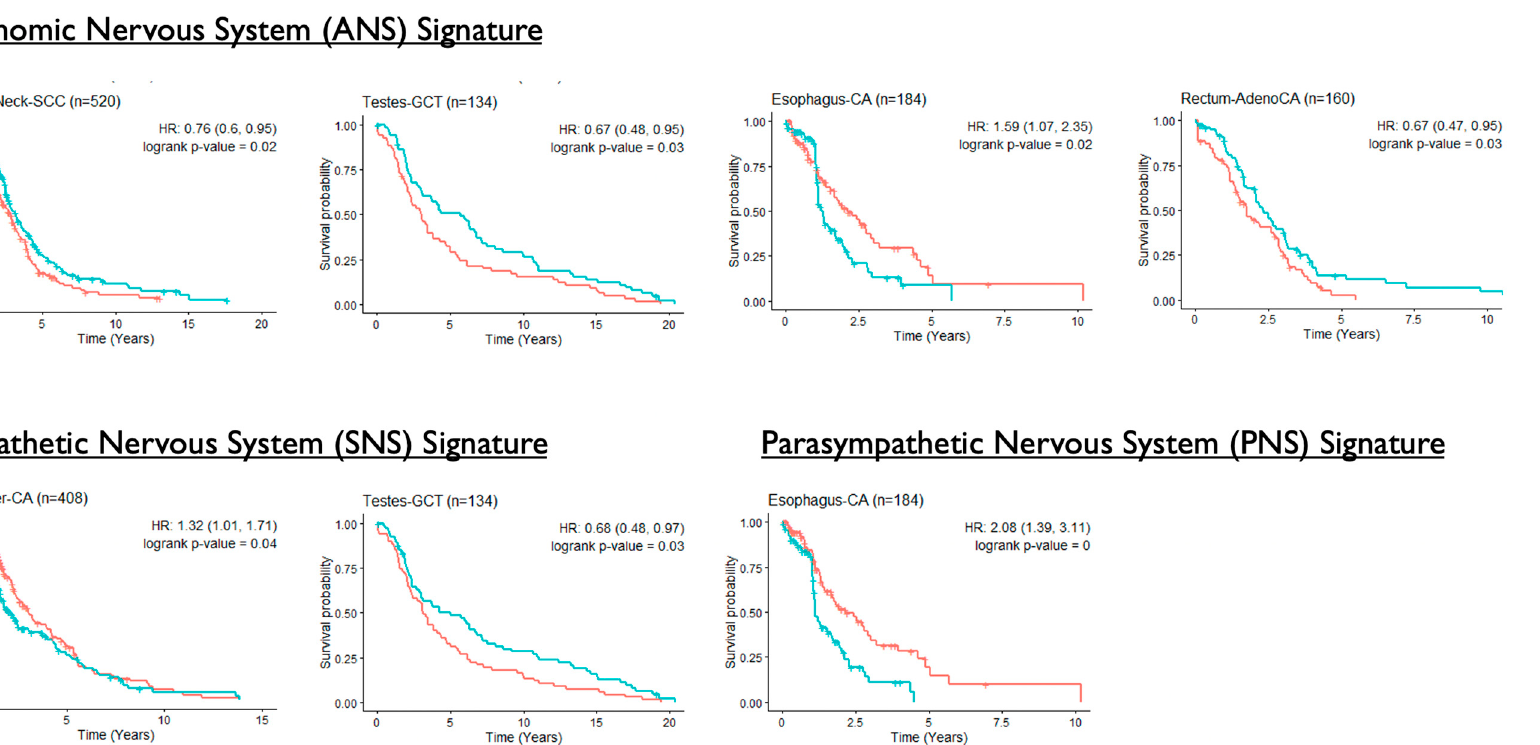
Figure 4. Kaplan–Meier curves of all-cause mortality by the levels of autonomic nervous system gene expression signatures. Red and blue lines represent low and high levels of signature levels, respectively, based on the median.